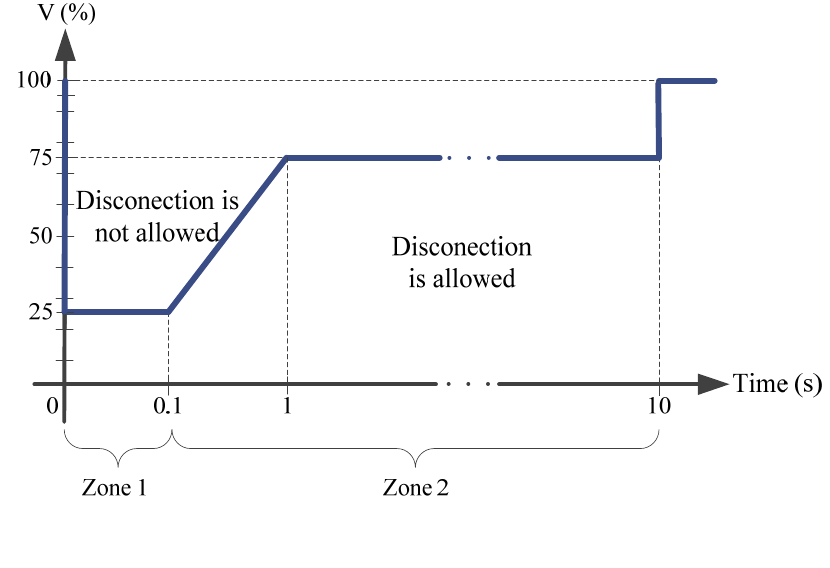
Figure 1. Low-voltage ride-through (LVRT) profile in the Danish grid